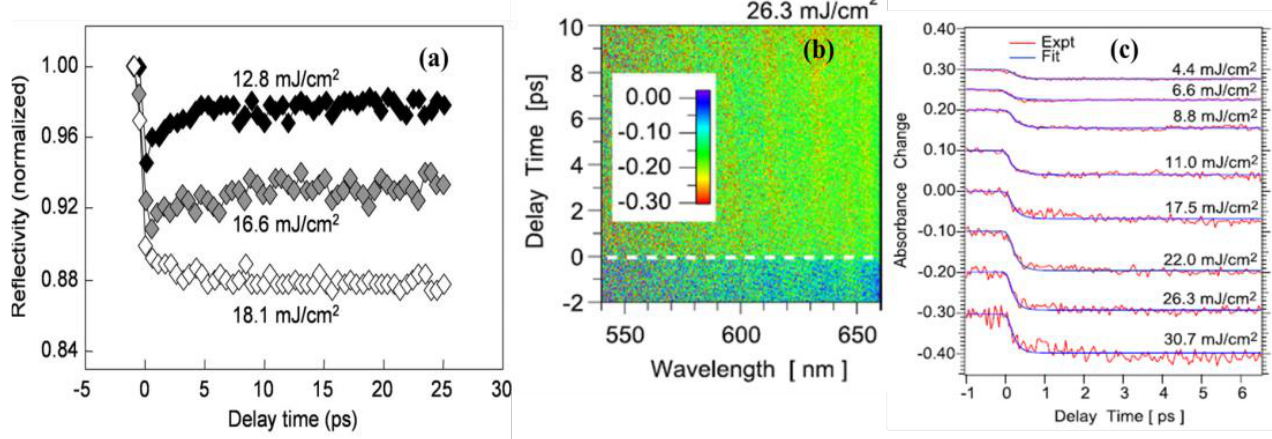
Figure 12. ( a ) Change in reflectivity of the probe pulse at different probe delays for fluence of 12.8, 16.6, and 18.1 mJ/cm 2 , respectively. All Figures are reprinted with permission from [64] Copyright 2014, American Institute of Physics. ( b ) 2D image of the TA in crystalline Ge-Sb-Te (GST) film for the laser fluence of 26.3 mJ/ cm 2 . ( c ) Temporal evolution of the absorbance in crystalline GST film in ps time domain for different laser fluences. All Figures are reprinted with permission from [65] Copyright 2014, American Institute of Physics.